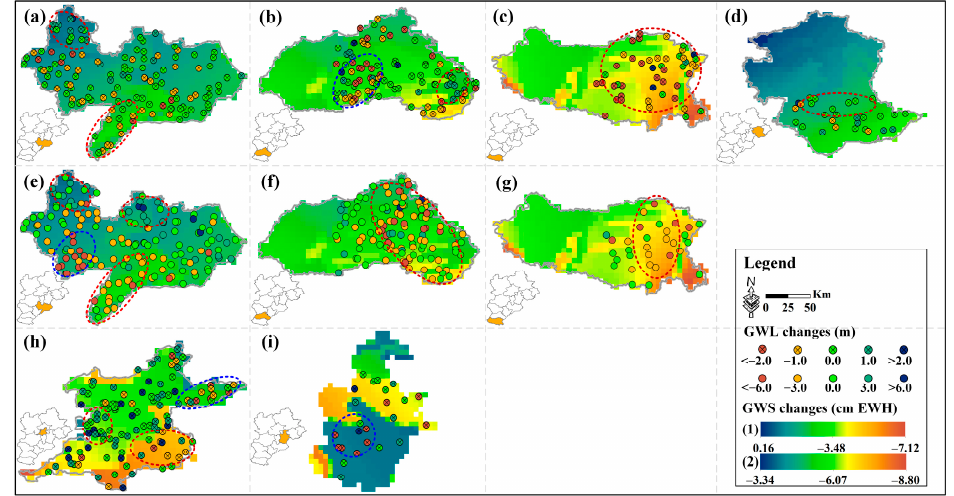
Figure 11. Comparison of GWL and GWS changes in different subregions. ( a – d ) represent the GWL changes in the shallow aquifers in Cangzhou, Xingtai, Handan, and Tangshan, ( e – g ) represent the GWL changes of deep aquifers (without Tangshan), and GWS changes with color bar (1) from December 2018 to December 2019; ( h , i ) represent the GWL changes in the shallow aquifer, and GWS changes with color bar (2) from December 2014 to December 2016 in Beijing and Tianjin.